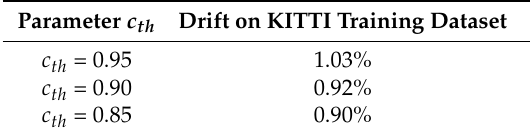
Table 2. The Influence of c th for Non Ground Features to the Result.